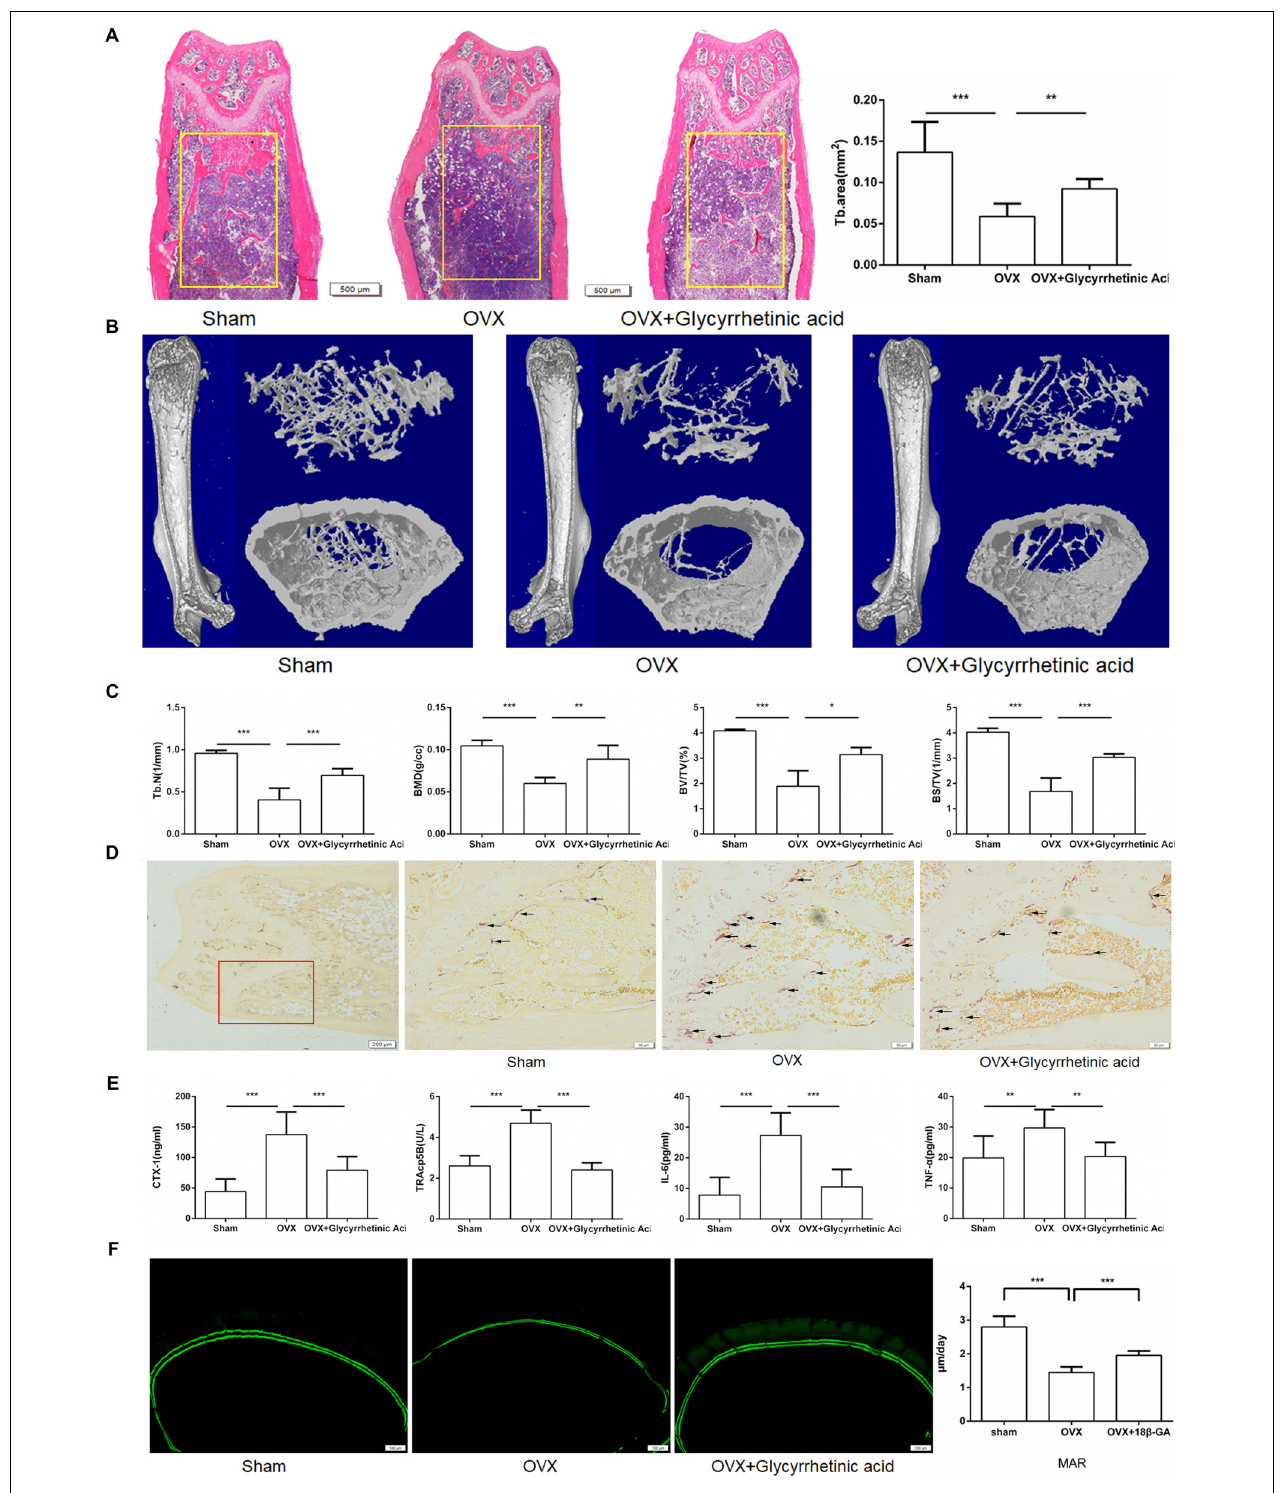
FIGURE 7 | 18 β -GA ameliorates ovariectomy-induced bone loss in vivo . (A) Representative HE staining of distal femoral sections and quantification of trabecular area from each group 6 weeks after the operation. (B) Micro CT analysis of the distal femur from sham, OVX, and OVX + 18 β -GA group. (C) Calculations of trabecular number (Tb.N), bone mineral density (BMD), bone surface area/total value (BS/TV) and bone value/total value (BV/TV). (D) Representative TRAP-stained histologic distal femur sections from sham, OVX and OVX + 18 β -GA group. (E) Serum IL-6, TNF- α , TRAcp5b, and CTX-1 were examined. (F) Calcein double labeling with a 7-day interval (Scale bar: 100 µ m). Mineral apposition rate (MAR) is significantly decreased in OVX mice and reversed by 18 β -GA ( ∗ P < 0.05, ∗∗ P < 0.01, ∗∗∗ P < 0.001).